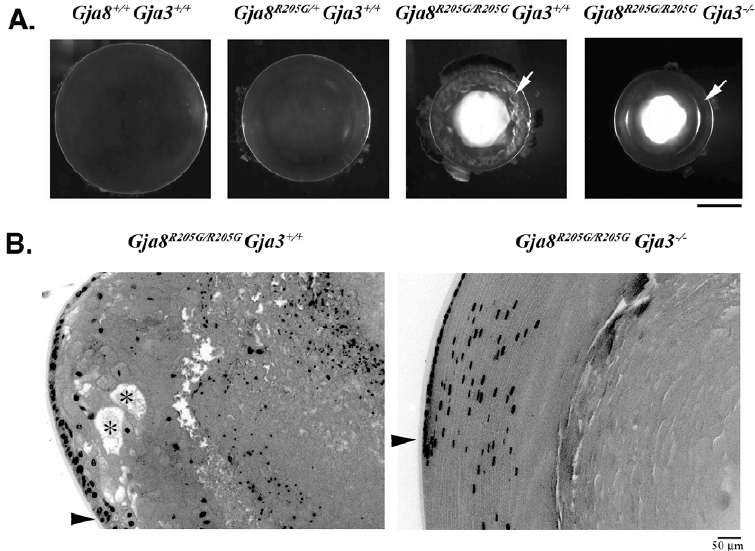
Figure 2. Endogenous Cx46 influences cataract formation caused by the Gja8 R205G mutation. ( A ) Lens photos of wild-type ( Gja8 + / + Gja3 + / + ), Gja8 R205G heterozygous ( Gja8 R205G/ + Gja3 + / + ), Gja8 R205G homozygous ( Gja8 R205G/R205G Gja3 + / + ), and Gja8 R205G Gja3 double mutant ( Gja8 R205G/R205G Gja3 2 / 2 ) mice at the age of 3 weeks. These mutant lines were bred into the C57BL/6J strain background. While the Gja8 R205G homozygous ( Gja8 R205G/R205G Gja3 + / + ) lens revealed vacuole-like defects in the lens periphery (indicated by a white arrow), the Gja8 R205G/R205G Gja3 2 / 2 double mutant lens showed a clear lens periphery (indicated by a white arrow). Scale bar, 1 mm. ( B ) Histological sections of Gja8 R205G homozygous mutant ( Gja8 R205G/R205G Gja3 + / + ) and Gja8 R205G Gja3 double mutant ( Gja8 R205G/R205G Gja3 2 / 2 ) lenses from 3-week-old littermates. The Gja8 R205G/R205G Gja3 + / + lens section showed disorganized peripheral fibers with vacuoles or enlarged extracellular spaces (labeled with asterisk) near the lens bow region (indicated by an arrowhead), while the double mutant lens section shows organized and elongated periphery fiber cells at the bow region (indicated by an arrowhead). Scale bar, 50 m m.